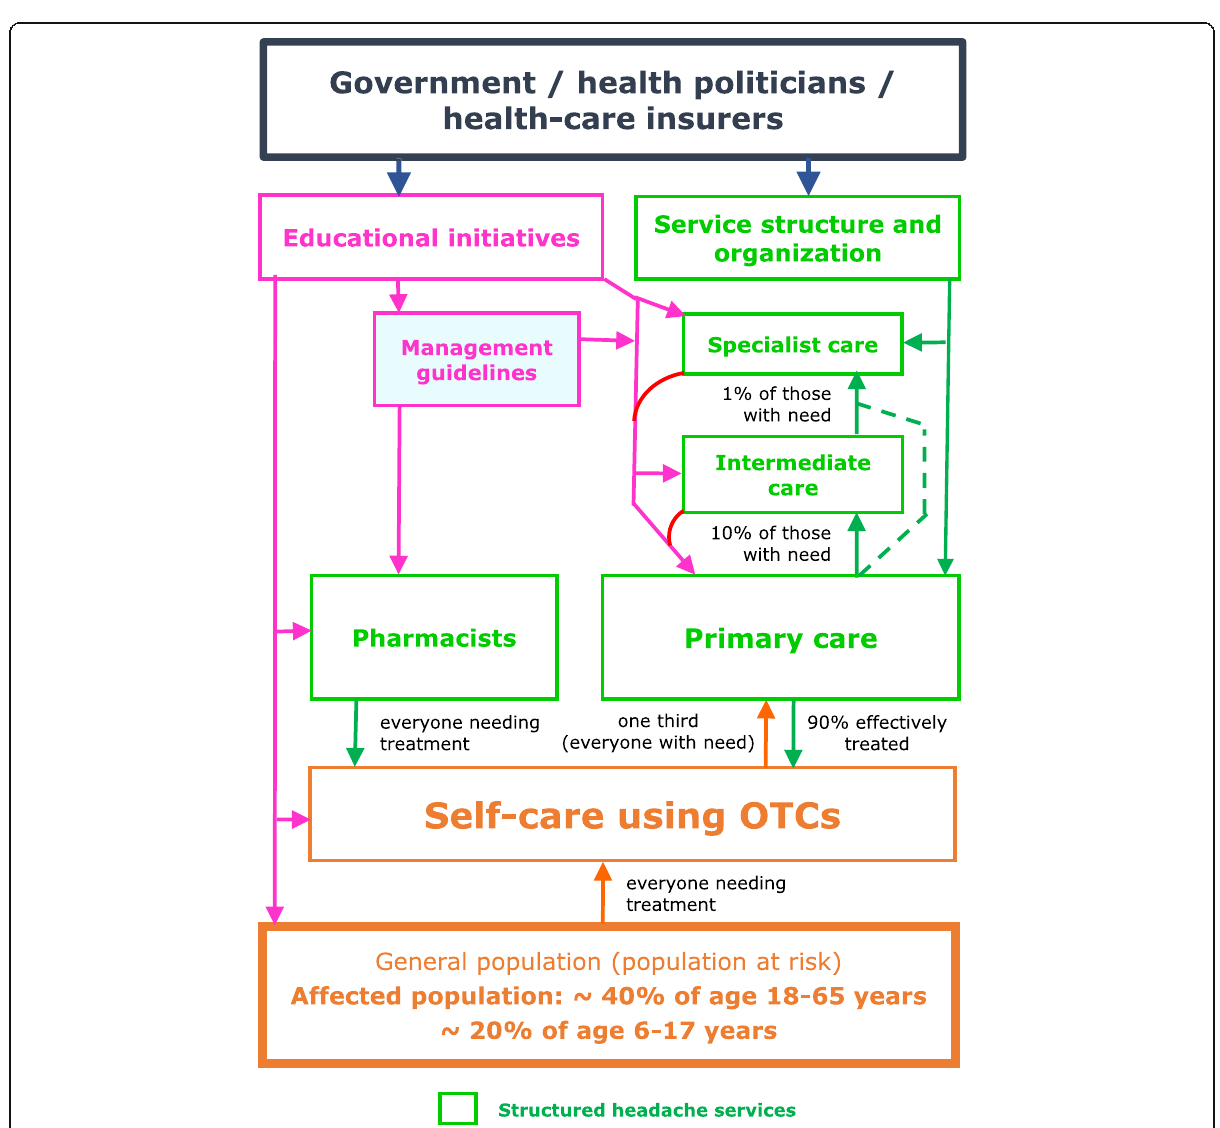
Fig. 2 Template for structured headache services supported by educational initiatives, and expected patient flows (adapted and updated from [26, 27]; see text for explanation)